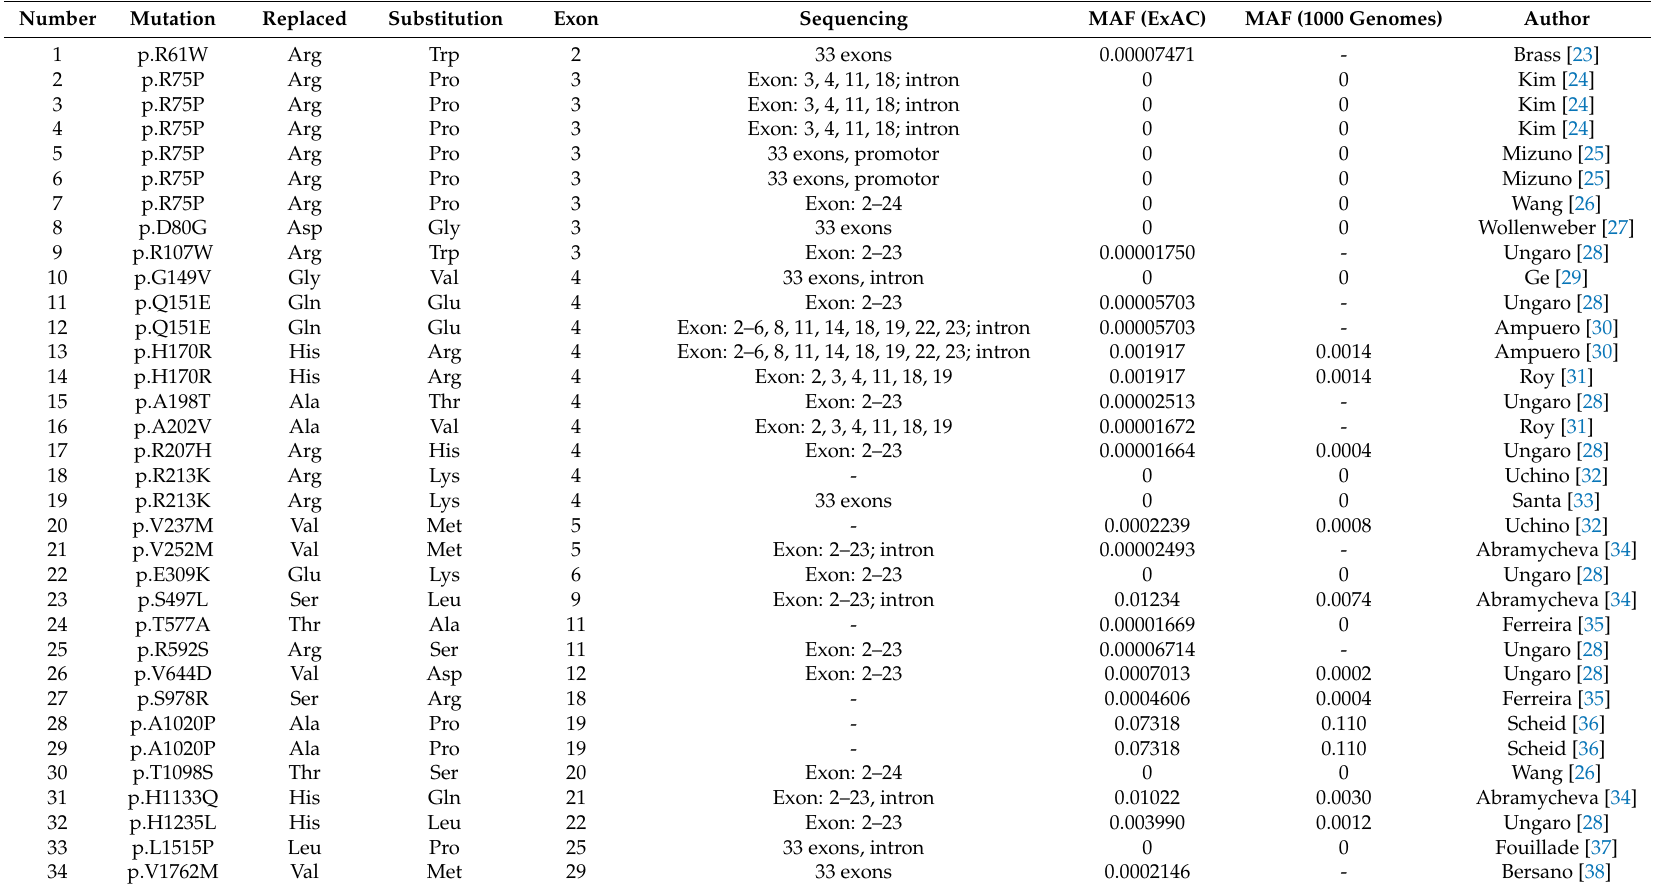
Table 1. Mutations found that do not affect cysteine amino